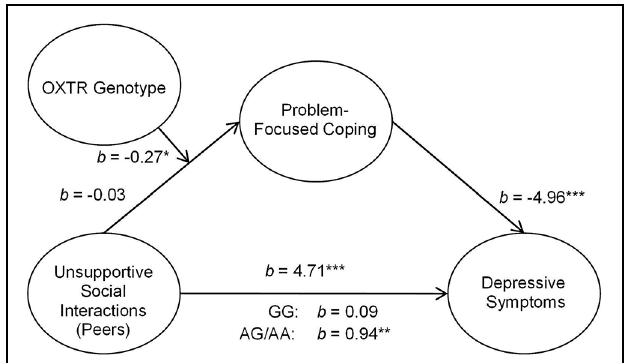
FIGURE 2 | Schematic of the moderated mediation analyses examining peer unsupport. The relation between unsupportive social interactions from peers and depressive symptoms through problem-focused coping was moderated by OXTR rs53576 genotype, only being significant among A carriers. ∗ p < 0.05, ∗∗ p < 0.01, and ∗∗∗ p <